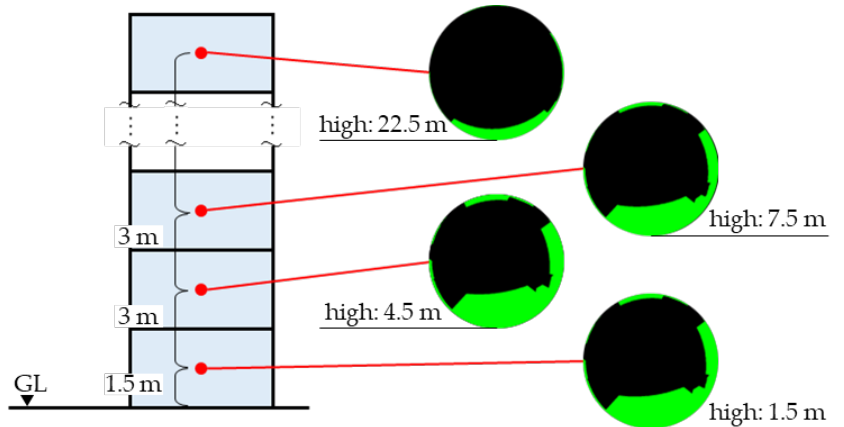
Figure 5. Setting height of center of gravity to create orthographic image.